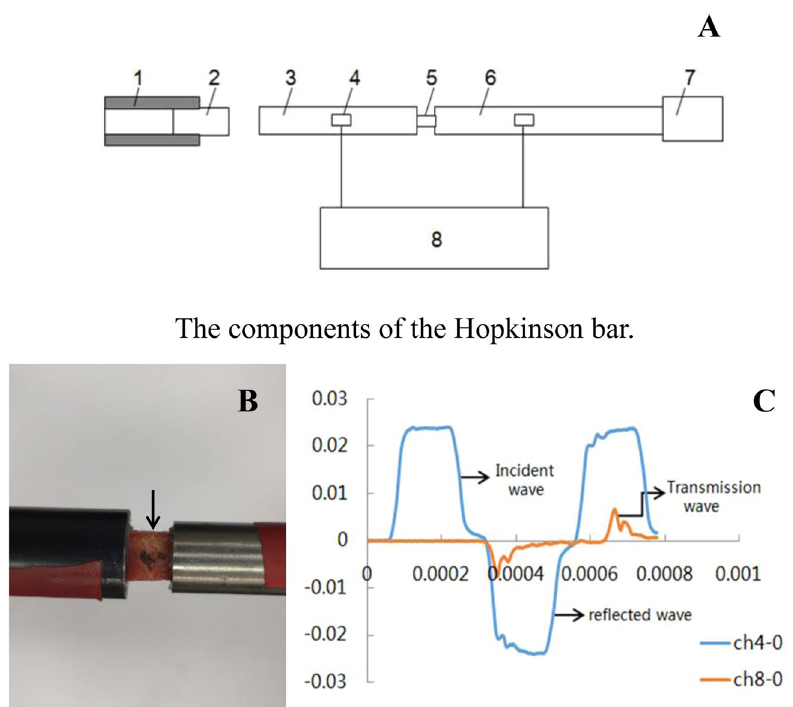
Figure 2. Schematic of Hopkinson bar and dynamic mechanical testing of rabbit femur. ( A ) Description of the Hopkinson bar. 1. Gas gun; 2. projectile; 3. Input bar; 4. strain gauge; 5. test sample; 6. output bar; 7. energy- absorbing device; 8. data acquisition and processing system ( B ) Fixation of the specimen on the Hopkinson bar (black arrow). ( C ) Incident wave, reflected wave, and transmitted wave, as recorded by the strain